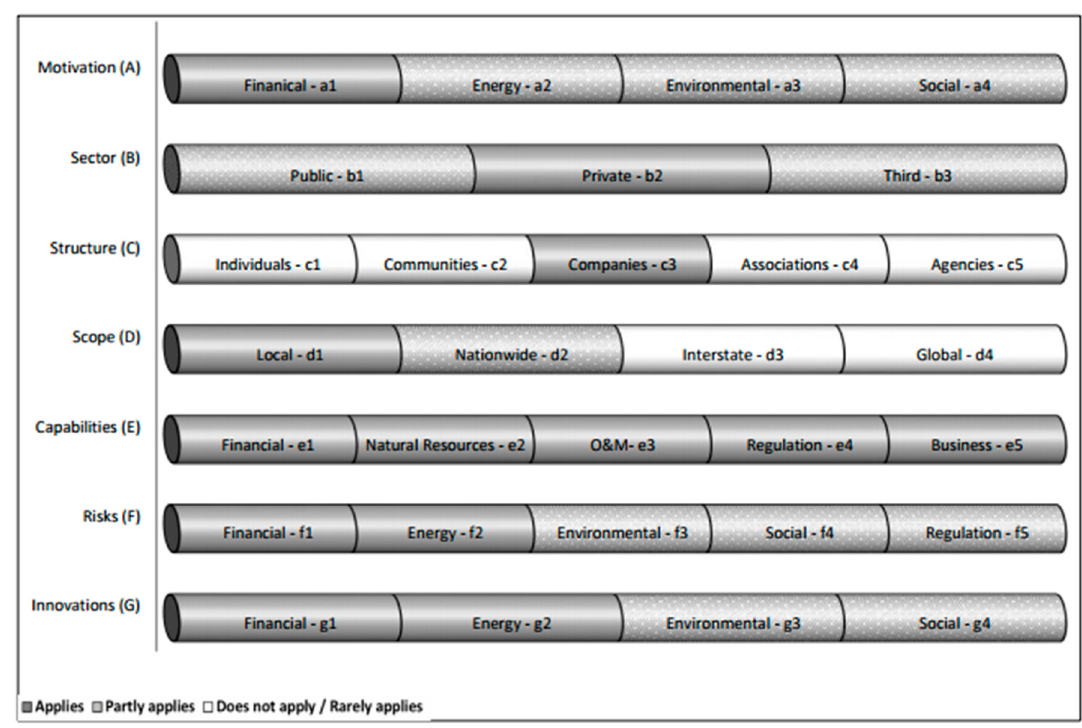
Figure 2. Schematic profile of a hypothetical RE entrepreneur.